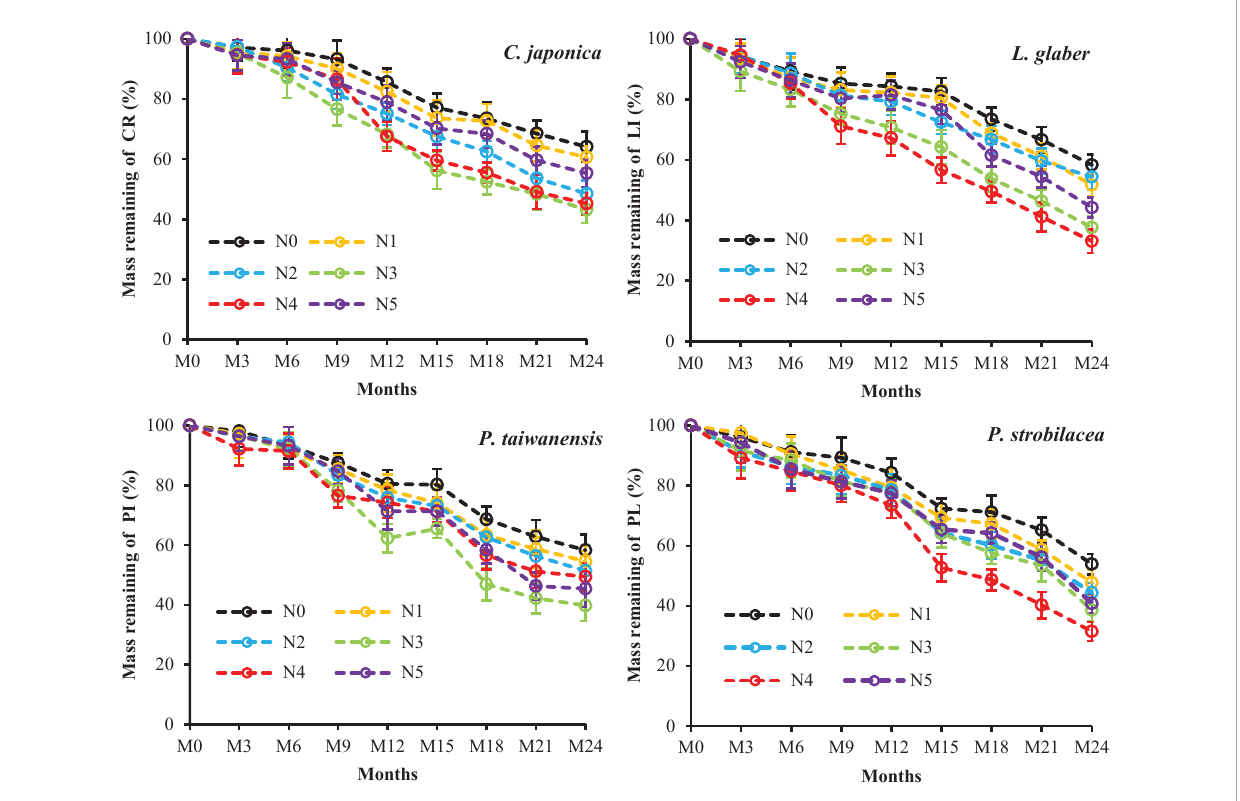
FIGURE1 Changes in the mass remaining of the four studied species during 24 months of wood decomposition under different forms of N fertilizer. Error bars indicate the standard error ( n = 6). N5, IN:ON = 0:10; N4, IN:ON = 3:7; N3, IN:ON = 5:5; N2, IN:ON = 7:3; N1, IN:ON = 10:0 and N0, control. Cryptomeria japonica ( C. japonica ), Platycarya strobilacea ( P. strobilacea ), Pinus taiwanensis ( P. taiwanensis ), and Lithocarpus glaber ( L. glaber